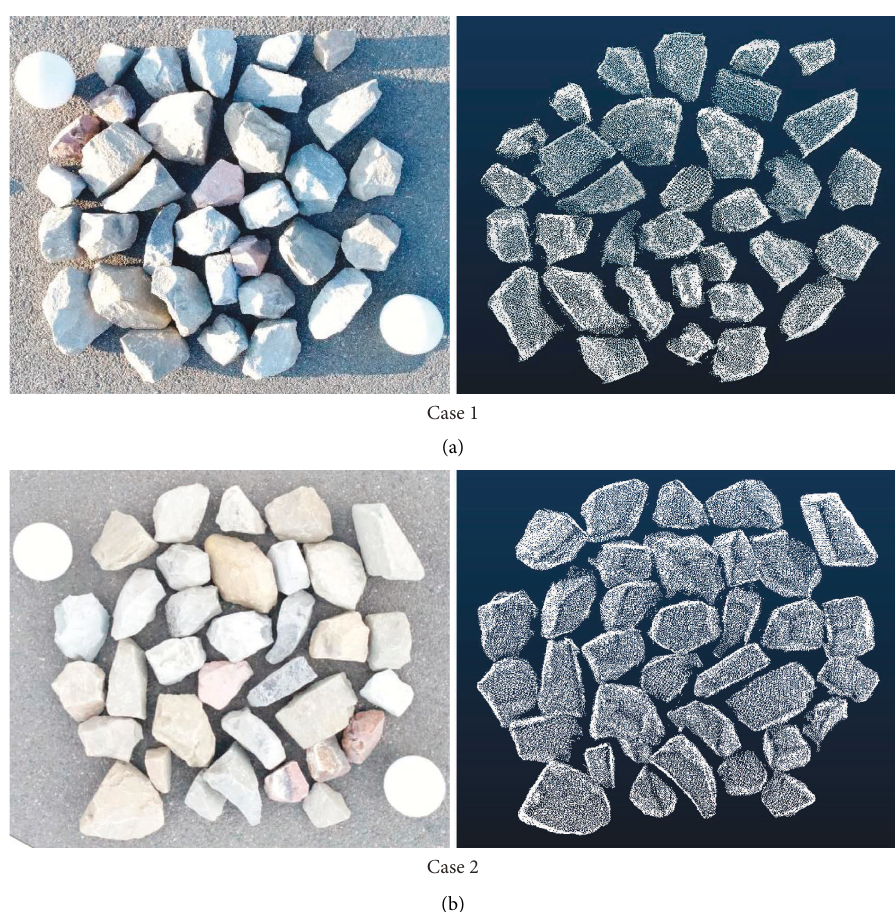
Figure 8: Scattered blocks with various layouts. (a) Case 1. (b) Case 2.